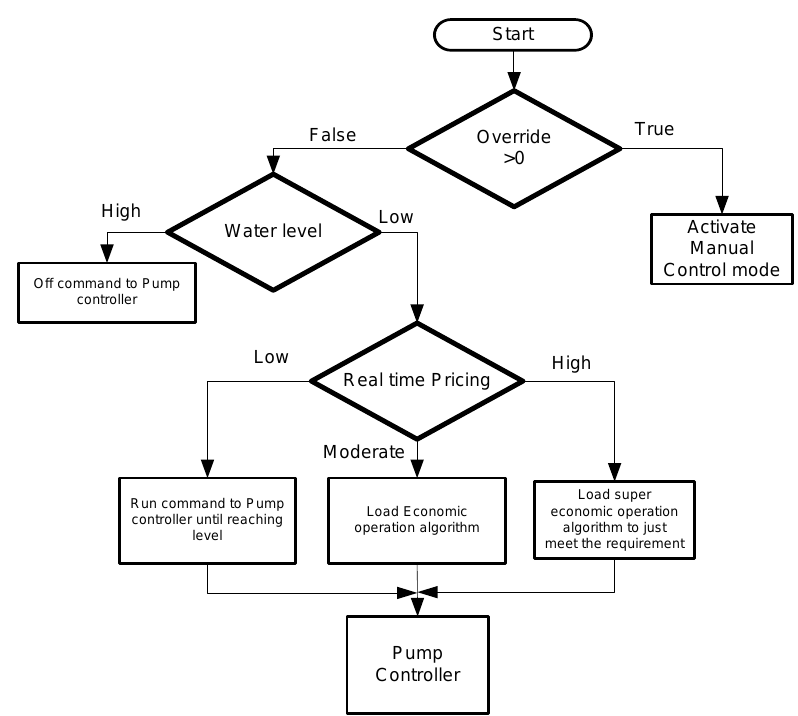
Figure 12. Water pump motor control flow chart.